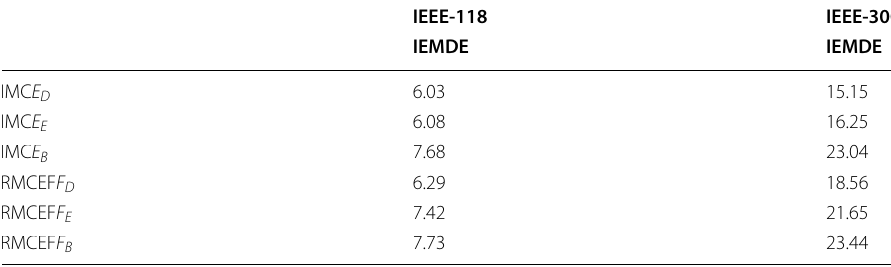
Table 7 Calculated ASM for IEEE test systems considered with primary sequence